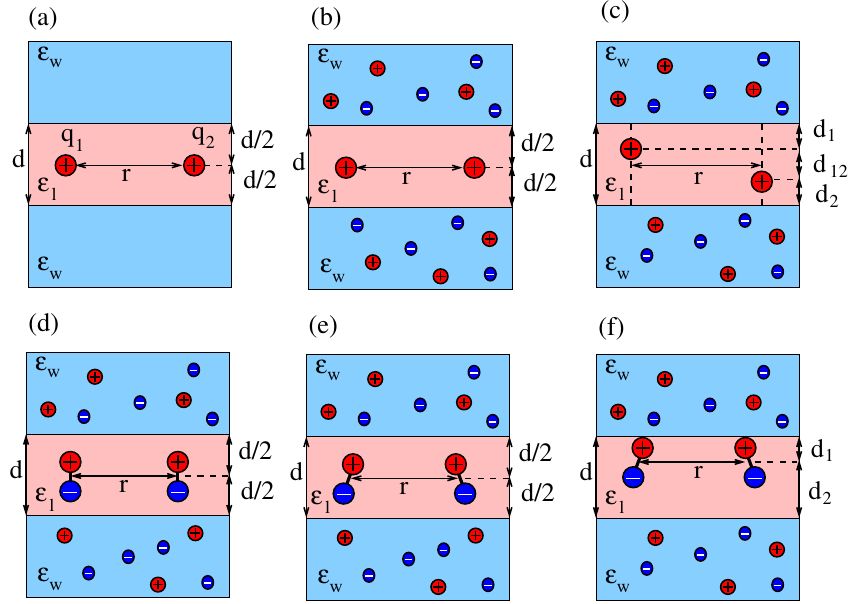
Figure 1. ( a ) Two interacting point charges, q 1 and q 2 , separated by a distance r in the middle of a dielectric slab of dielectric constant (cid:101) l and thickness d . The dielectric constant of the sandwiching media is (cid:101) w . ( b ) Salt ions with bulk concentration n 0 are present in the two sandwiching media. ( c ) The two interacting charges are moved up or down so that their mutual distance is their distances to the dielectric interfaces are d 1 and d 2 , with d 1 + d 2 + d 12 = d . ( d ) The two charges in diagram b are replaced by two dipoles, both located at the middle of and oriented normal to the dielectric slab, either parallel (as shown) or anti-parallel (not shown). ( e ) Two dipoles as in diagram d, yet with arbitrary orientations. ( f ) The two interacting dipoles shown in diagram e are jointly moved up or down so that their distances to the dielectric interfaces are d 1 and d 2 , with d 1 + d 2 = d